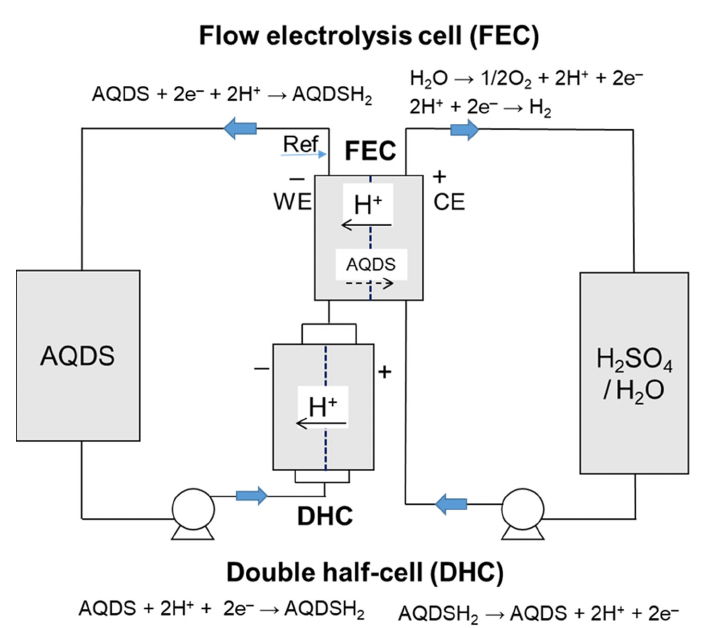
Figure 2. Scheme of experimental set-up for evaluation of the electrochemical stability of AQDS